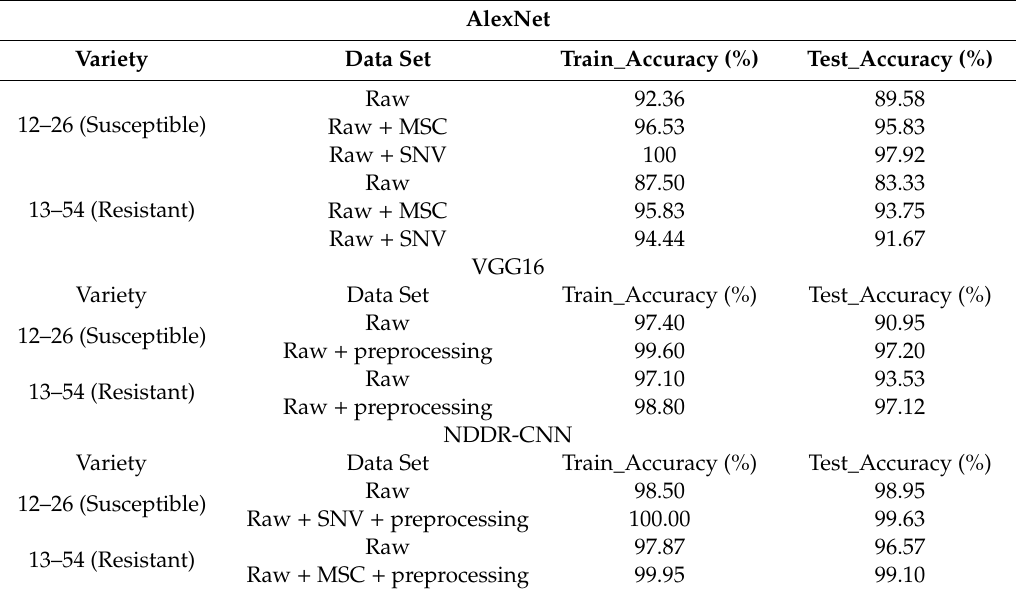
Table 4. The classification accuracy of the three models to detect black